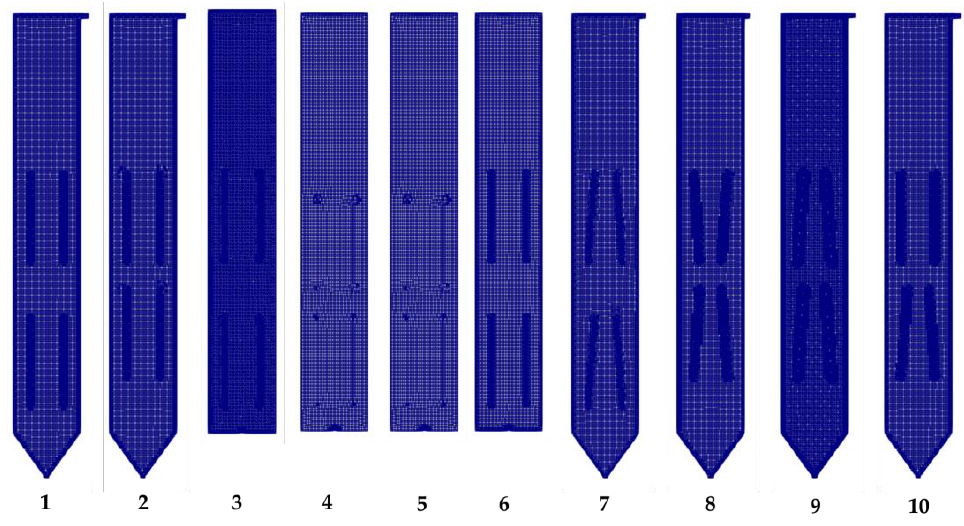
Figure 4. Mesh of geometries 1, 2, 3, 4, 5, 6, 7, 8, 9 and 10. Geometries 4 and 5 were the only two without wall refinement. For the other geometries a wall refinement of 1 level and 2 cells in between levels. To illustrate the mesh, geometry 8 has been chosen for a close up to view the wall refinement at the draft tube section, inlet, outlet and walls, as shown in Figure 5.